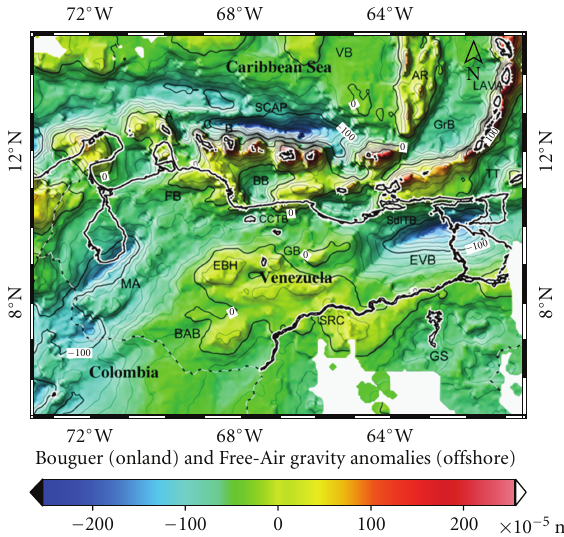
Figure 3: Gravity anomaly map of Venezuela. Complete Bouguer anomalies are given on land, and Free-Air anomalies are o ff shore. The Bouguer reduction density was 2.67 Mg/m 3 . Contour interval: 20 × 10 − 5 m/s 2 . Geographical coordinates. Geological features